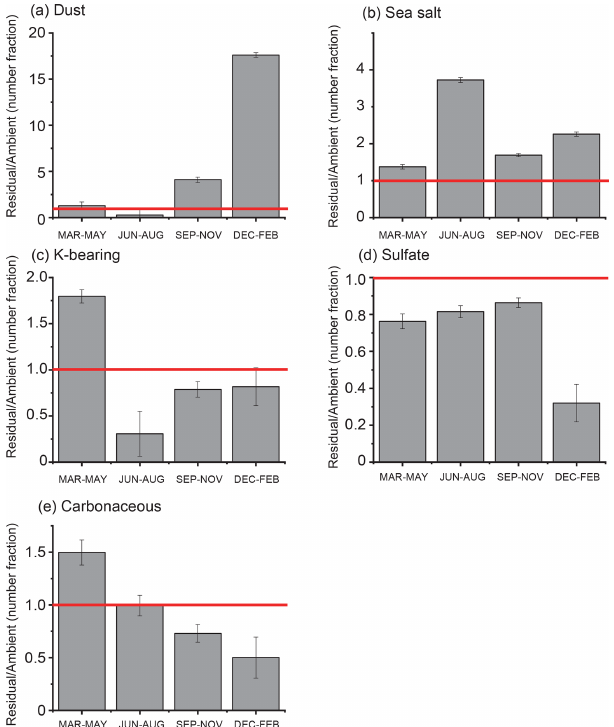
Figure 9. Ratios of number fractions of each particle type be- tween cloud residual and ambient aerosol samples for each season. (a) Mineral dust particles, (b) sea salt particles, (c) K-bearing parti- cles, (d) sulfate particles, and (e) carbonaceous particles. Red lines indicate that the ratio is equal to 1. Errors are based on Poisson